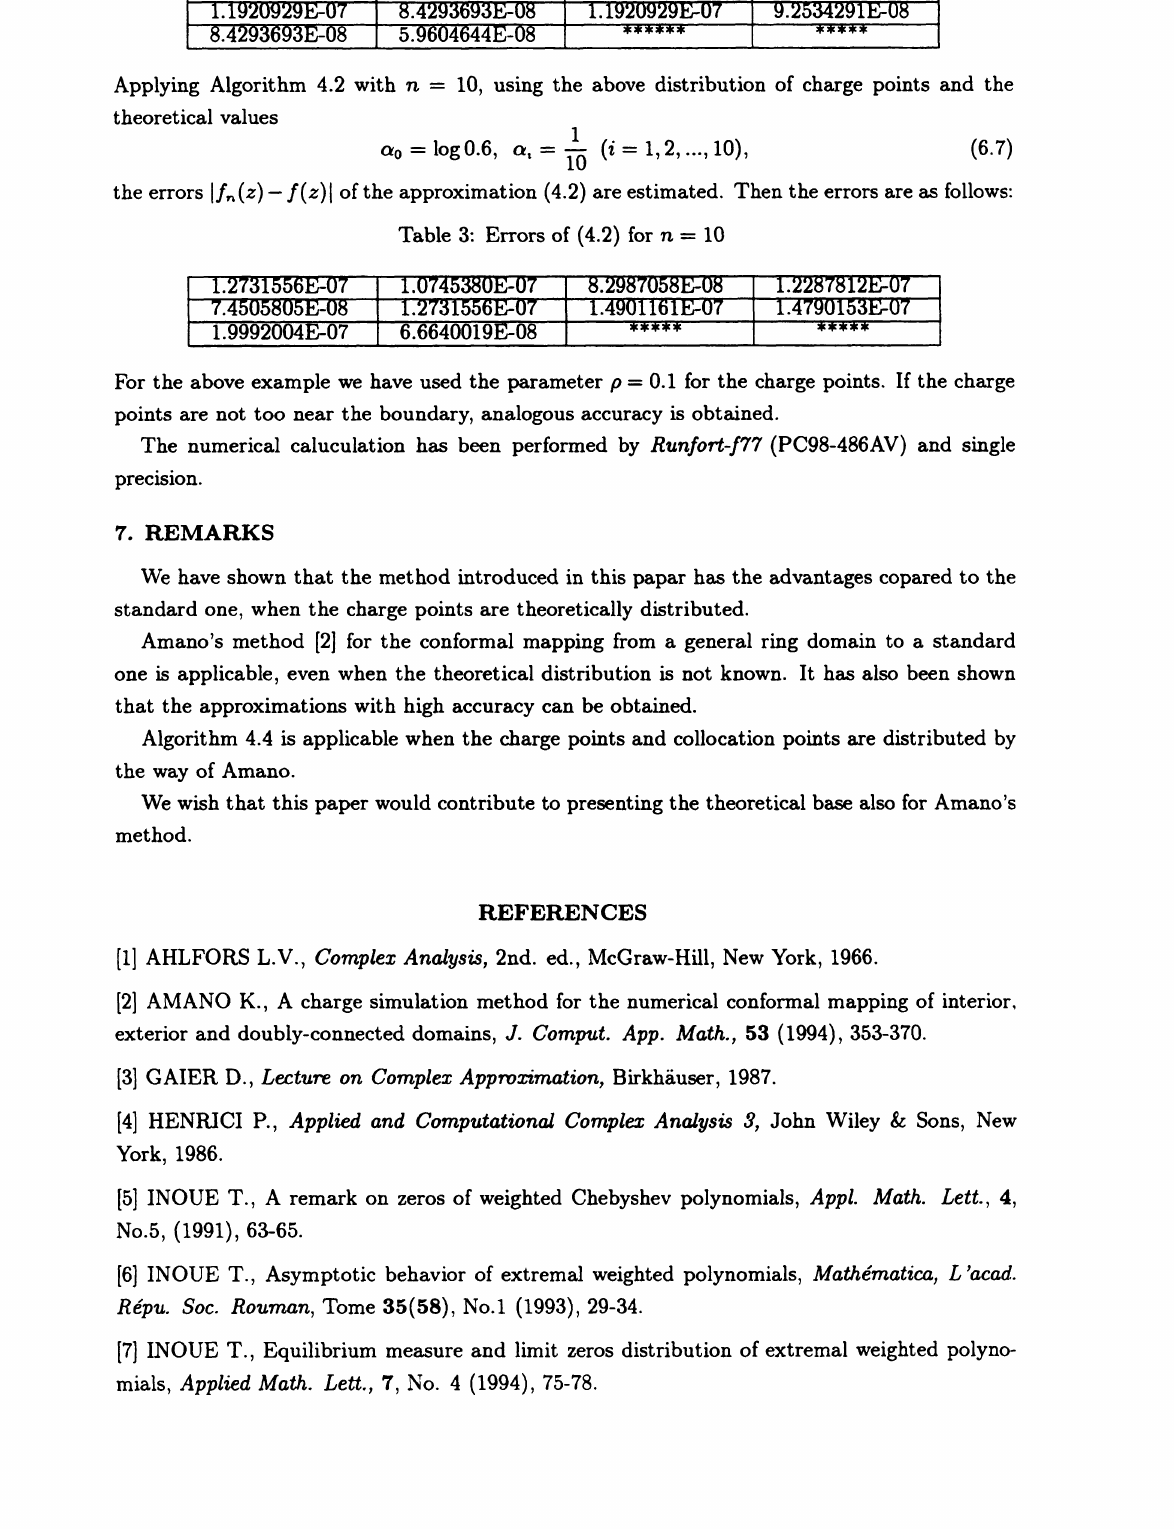
Table 3: Errors of (4.2) for n